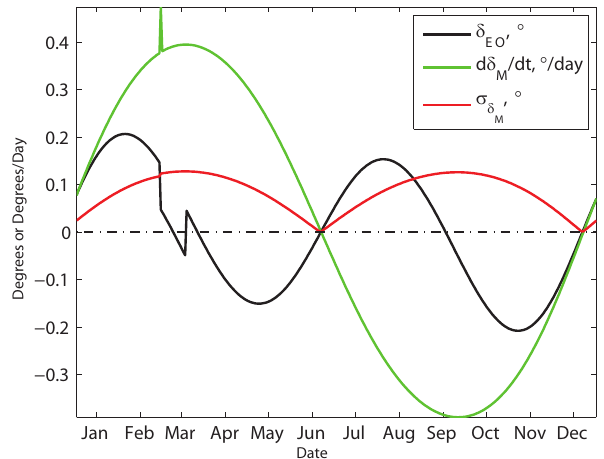
Figure 6. Solar declination validation: difference between solar declination as computed by the internal geometry of the Earth or- bit model (using the La2004 orbital parameters for J2000) and mean actual declination from the years 2009, 2010, 2011 and 2012 as computed for 12:00:00UT every day with the algorithms in Meeus (1998) (black solid line). The rate of change of declina- tion (green solid line) and the standard deviation of declination for each date for the four years (red solid line, N = 4 for each data point) are also shown for reference. The model computations were performed with the calendar start date fixed at vernal equinox of 20 March. The date 29 February 2012 was removed from the anal- ysis, so the abscissa corresponds to a given date, that is, dates, not days of year were averaged for a given mean solar declination across the four years. Abscissa ticks represent the 15th of each month. If 00:00UT is used for the Meeus computations instead, differences (black curve) have a different pattern and are larger, but never ex- ceed ∼ 0.4 degrees (not shown). See Sect. 5.2 for